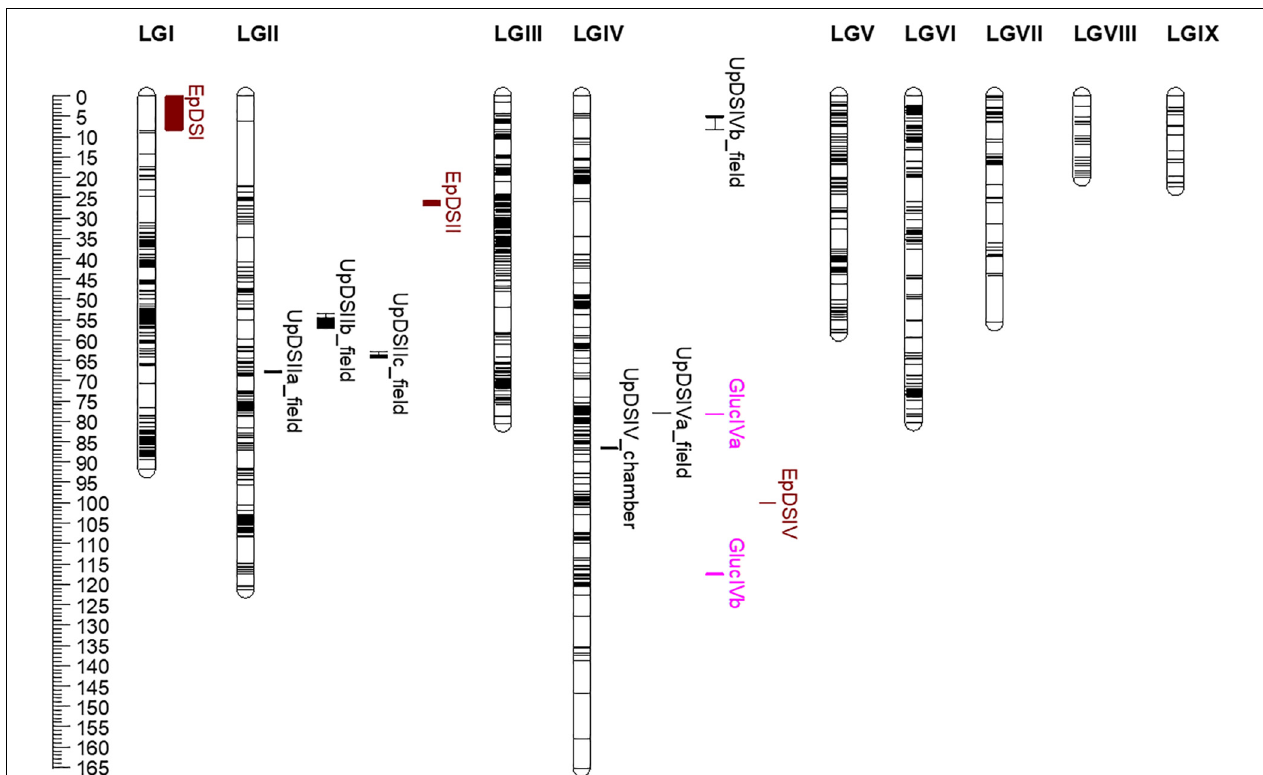
FIGURE 3 | Phenotypic quantitative trait loci (pQTLs, in black) and expression QTLs (eQTLs, in pink) for rust ( Uromyces pisi ) inoculation response mapped on linkage groups (LG) of the high-density Lathyrus cicera genetic linkage map based on a recombinant inbred line population (BGE023542 × BGE008277) (Santos et al., 2020). Genetic distances given in centimorgans (Kosambi mapping function) are indicated by the ruler on the left. Horizontal black lines indicate marker positions along LGs. Boxes, extended by lines depicting the 1-LOD confidence interval, represent pQTL/eQTL intervals: in black pQTLs identified for U. pisi DS (disease severity [%]), under semi-controlled field conditions and growth chamber conditions; eQTLs are represented in pink ( GlucIVa and GlucIVb ). In brown are represented pQTL intervals for powdery mildew disease response ( Erysiphe pisi and E. trifolii ), previously identified in the same L. cicera RIL population (Santos et al., 2020).